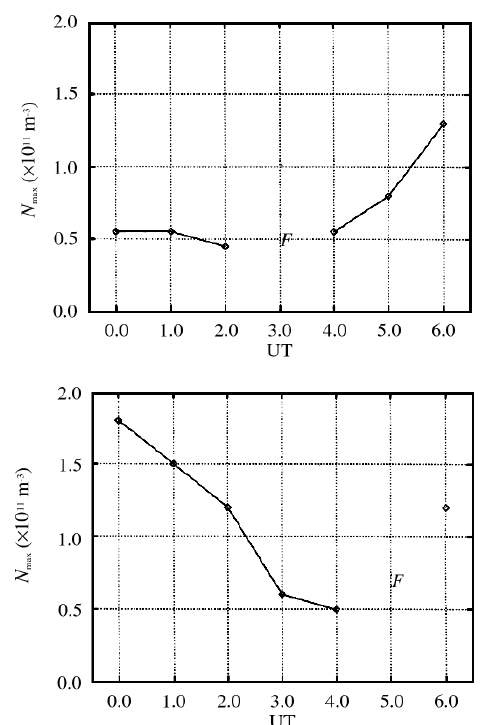
Fig. 2. Estimates of peak electron density ( NmF 2) obtained from the ionosondes at Chilton ( left upper ) and Lannion ( left lower ) as a function of time, togeth- er with ( right ) tomographic images from satellite passes at three times throughout the night. The F de- notes spread- F conditions. From Kersley et al. (1997), reproduced by permission of the American Geophysi- cal